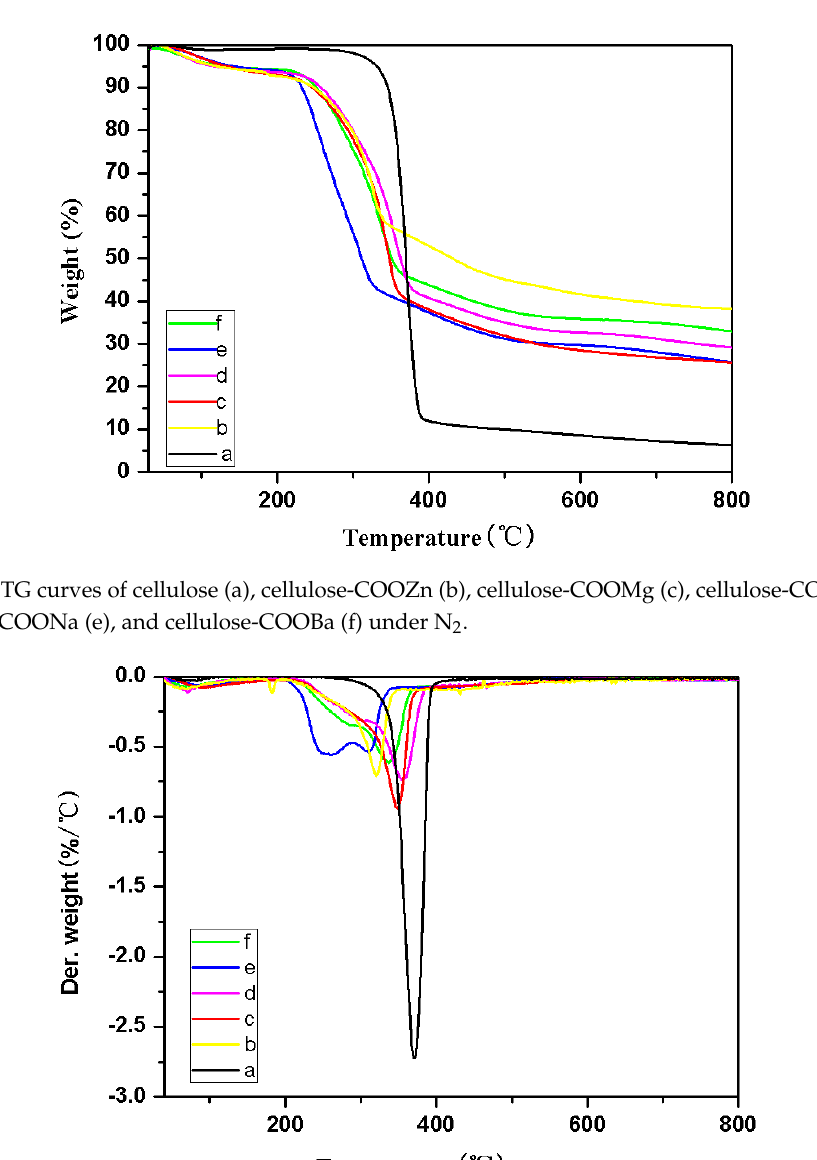
Figure 6. DTG curves of cellulose (a), cellulose-COOZn (b), cellulose-COOMg (c), cellulose-COOCa (d), cellulose-COONa (e), and cellulose-COOBa (f) under N 2. Table 1. The TG and DTG data of cellulose and TEMPO-oxidized cellulose (TOC).